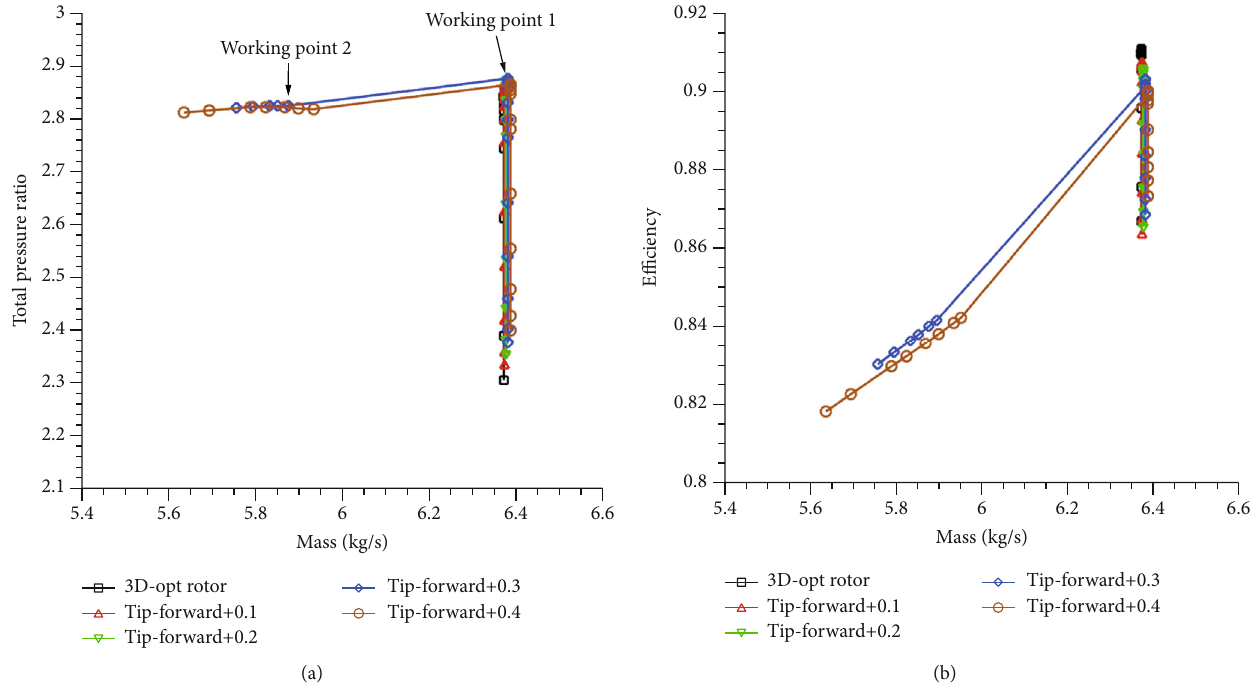
Figure 20: Performance curves of the fi ve rotors with di ff erent forward sweeps of blade